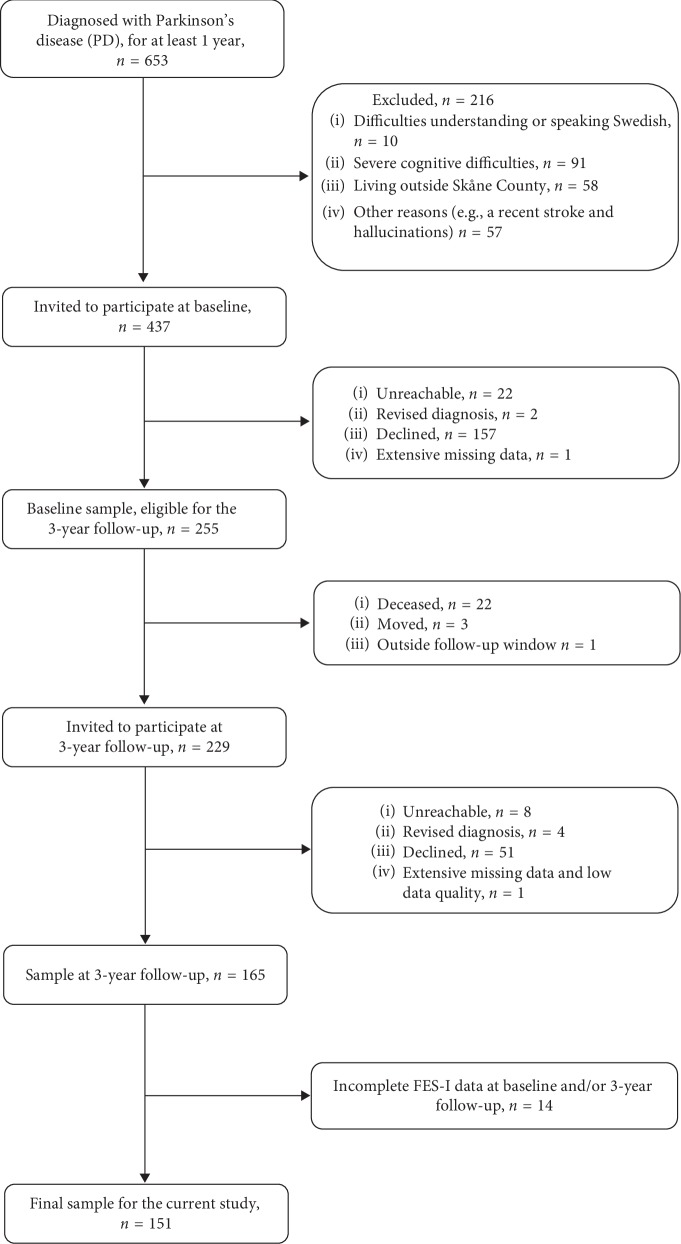
Flowchart: participant recruitment process.